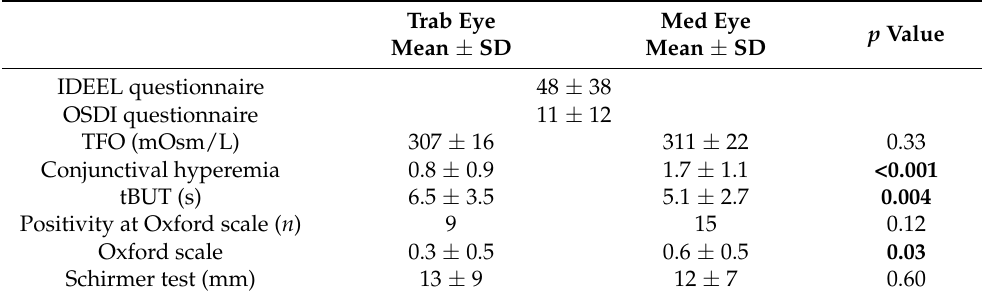
Table 2. Results of questionnaires and ocular surface parameters in the differently treated